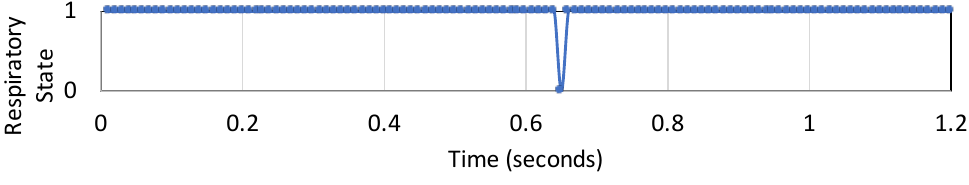
Figure 4. Respiratory state corresponding to features shown in Figure